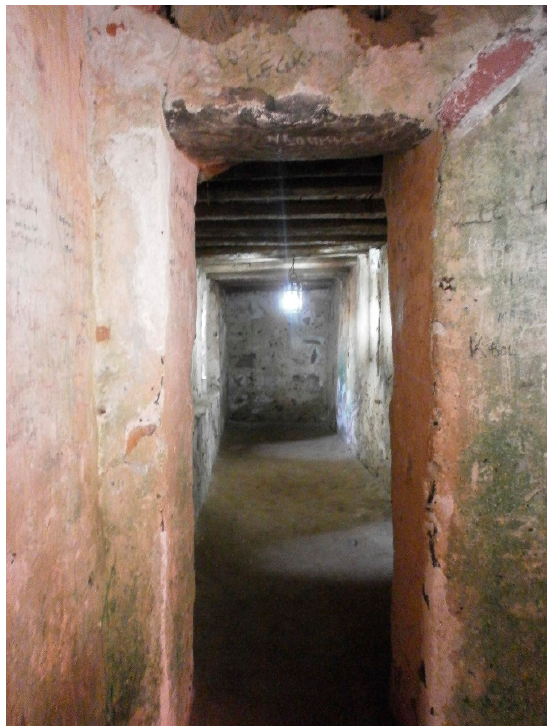
Figure 3. Passageway to Prisoners’ Cells ( Cellules, Maison des Esclaves ). Wikimedia Commons (photo by HaguardDuNord).